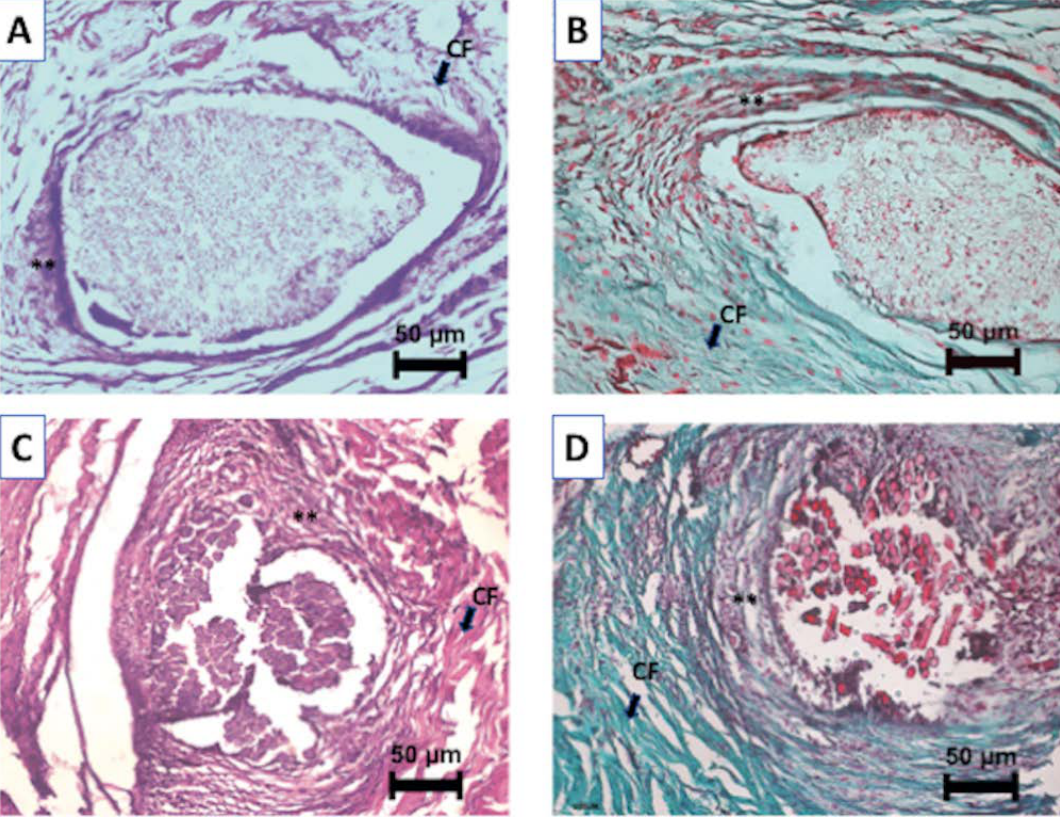
Figure 10. Representative micrographs from the histologic examination of sections: ( A ) implanted with PMMA, Haematoxylin & Eosin 200 × ; ( B ) implanted with PMMA, Masson’s Trichrome 200 × ( C ) implanted with experimental group, Haematoxylin & Eosin 200 × ; ( D ) implanted with experimental group, Masson’s Trichrome 200 × . CF: Collagen fibres, **: Granulation